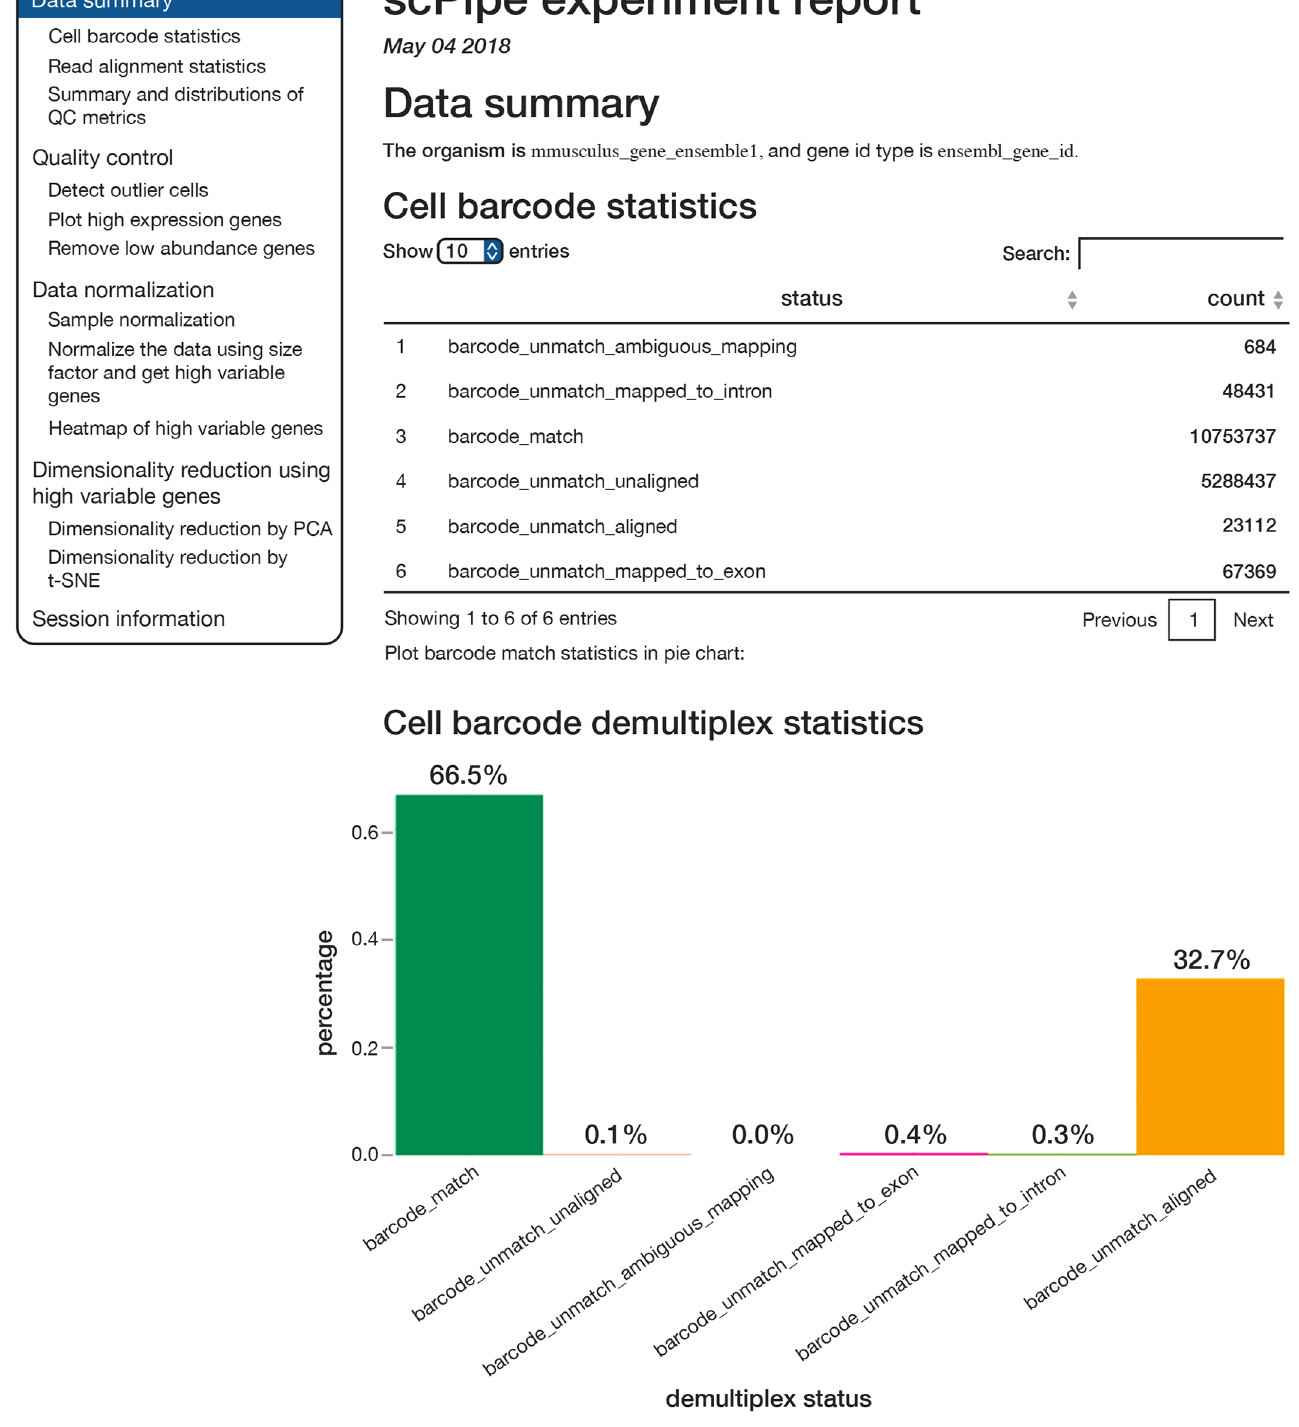
Fig 4. Screenshot of an HTML report created by scPipe for the mouse blood cell dataset. This report organises the output of scPipe , including run parameters and QC metrics and also generates basic dimension reduction plots of the data. Such reports provide a convenient format for communicating basic QC information to collaborators to help them evaluate the overall quality of an